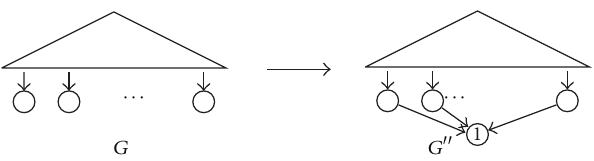
Figure 2: The construction involved in the reduction of the isomorphism of rDAGs to the isomorphism of 𝑆